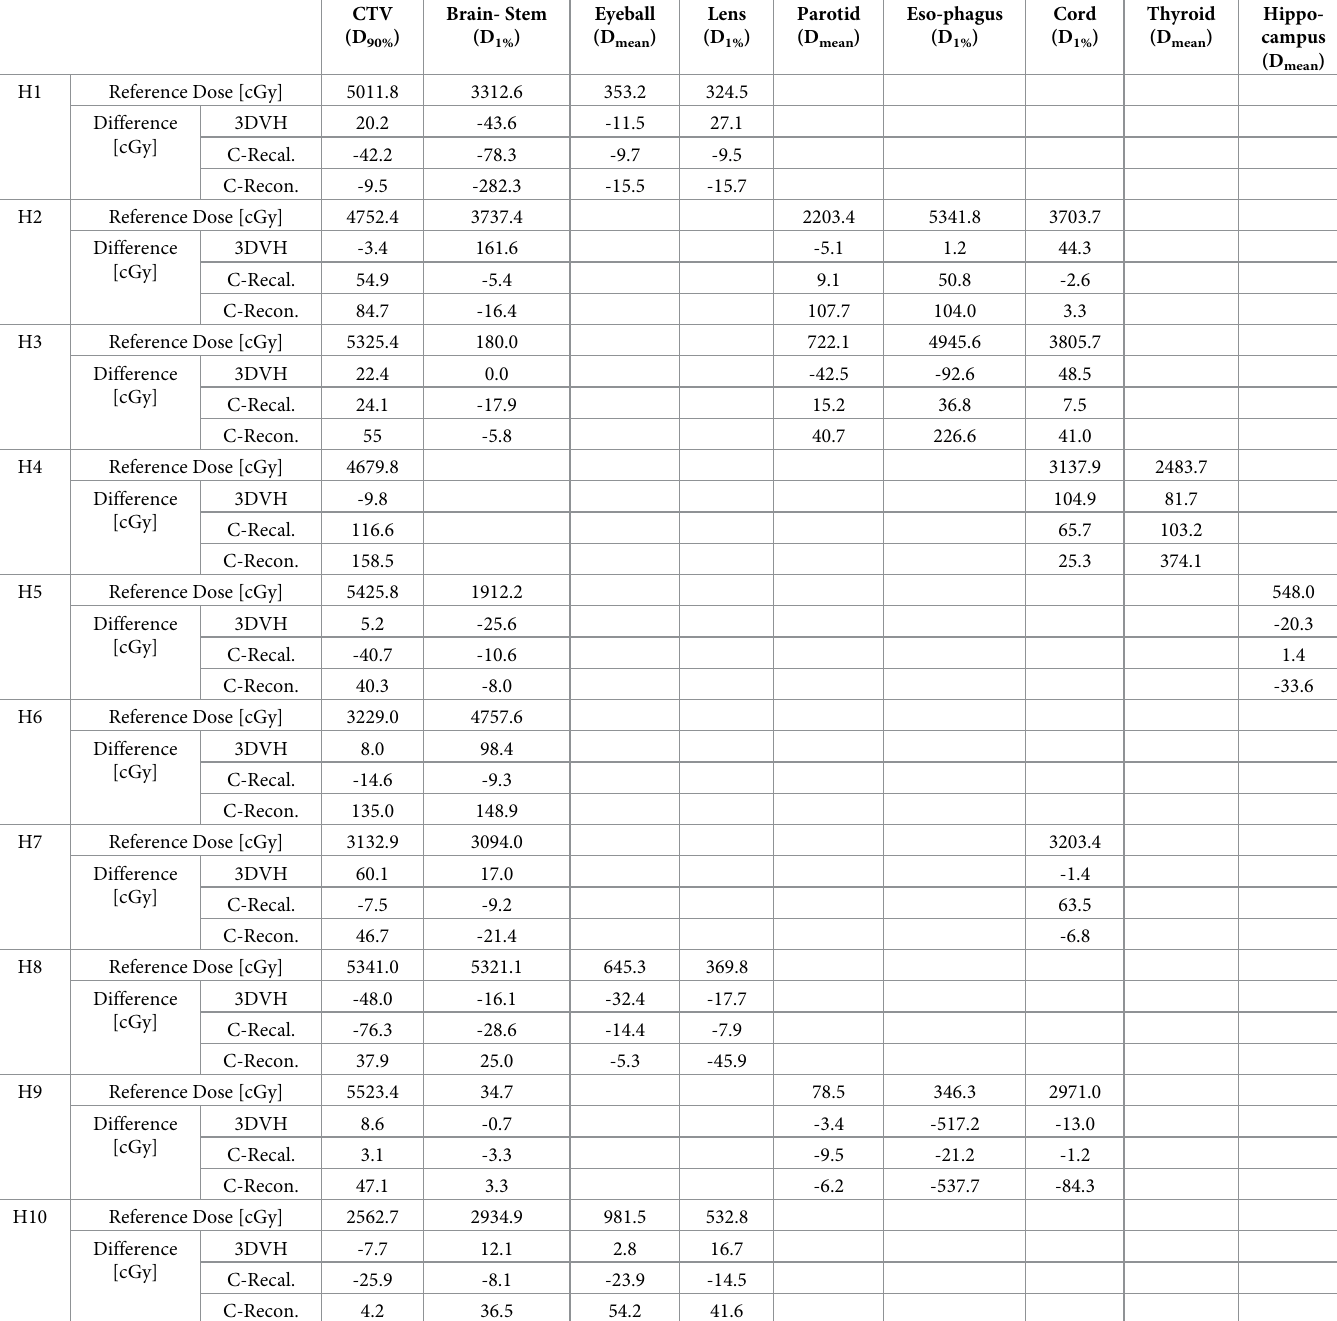
Table 6. Differences in dose metrics of tumor target and OARs calculated using 3DVH and compass (C-Recal.: Compass Recalculation, C-Recon.: Compass Recon- struction) for the Head-Neck plans compared with a reference dose calculated using Eclipse